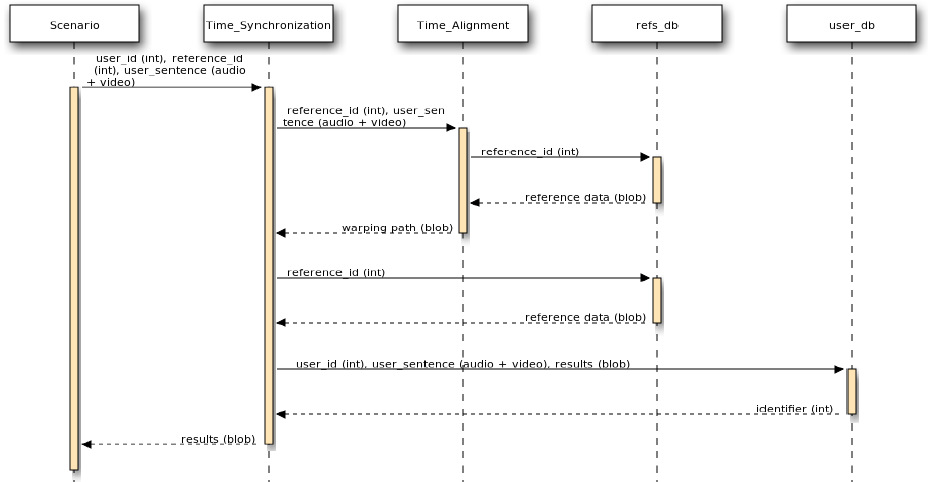
Figure 3 | A sequence diagram depicting the communication between the developed components according to the modular